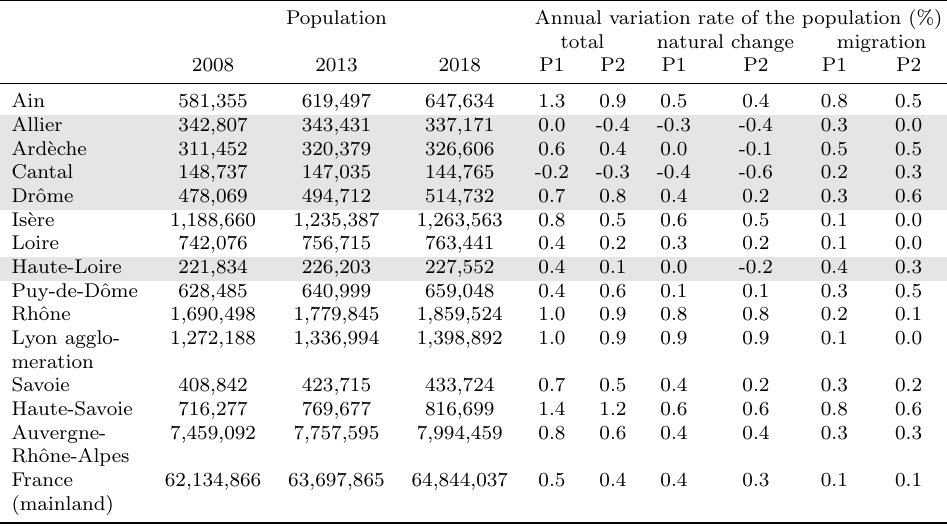
Table 3: Evolution of the population between 2008, 2013 and 2018 per county, AURA region Population Annual variation rate of the population (%) total natural change migration 2008 2013 2018 P1 P2 P1 P2 P1 P2 Ain 581,355 619,497 647,634 1.3 0.9 0.5 0.4 0.8 0.5 Allier 342,807 343,431 337,171 0.0 -0.4 -0.3 -0.4 0.3 0.0 Ard`eche 311,452 320,379 326,606 0.6 0.4 0.0 -0.1 0.5 0.5 Cantal 148,737 147,035 144,765 -0.2 -0.3 -0.4 -0.6 0.2 0.3 Drˆome 478,069 494,712 514,732 0.7 0.8 0.4 0.2 0.3 0.6 Is`ere 756,715 0.4 0.2 0.3 0.2 0.1 221,834 226,203 227,552 0.4 0.1 0.0 -0.2 0.4 0.3 Puy-de-Dˆome 628,485 640,999 659,048 0.4 0.6 0.1 0.1 0.3 0.5 Rhˆone 1,690,498 1,779,845 1,859,524 1.0 0.9 0.8 0.8 0.2 0.1 Lyon agglo- 1,272,188 1,336,994 1,398,892 1.0 0.9 0.9 0.9 0.1 0.0 meration Savoie 408,842 423,715 433,724 0.7 0.5 0.4 0.2 0.3 0.2 Haute-Savoie 716,277 769,677 816,699 1.4 1.2 0.6 0.6 0.8 0.6 Auvergne- 7,459,092 7,757,595 7,994,459 0.8 0.6 0.4 0.4 0.3 0.3 Rhˆone-Alpes France 62,134,866 63,697,865 64,844,037 0.5 0.4 0.4 0.3 0.1 0.1